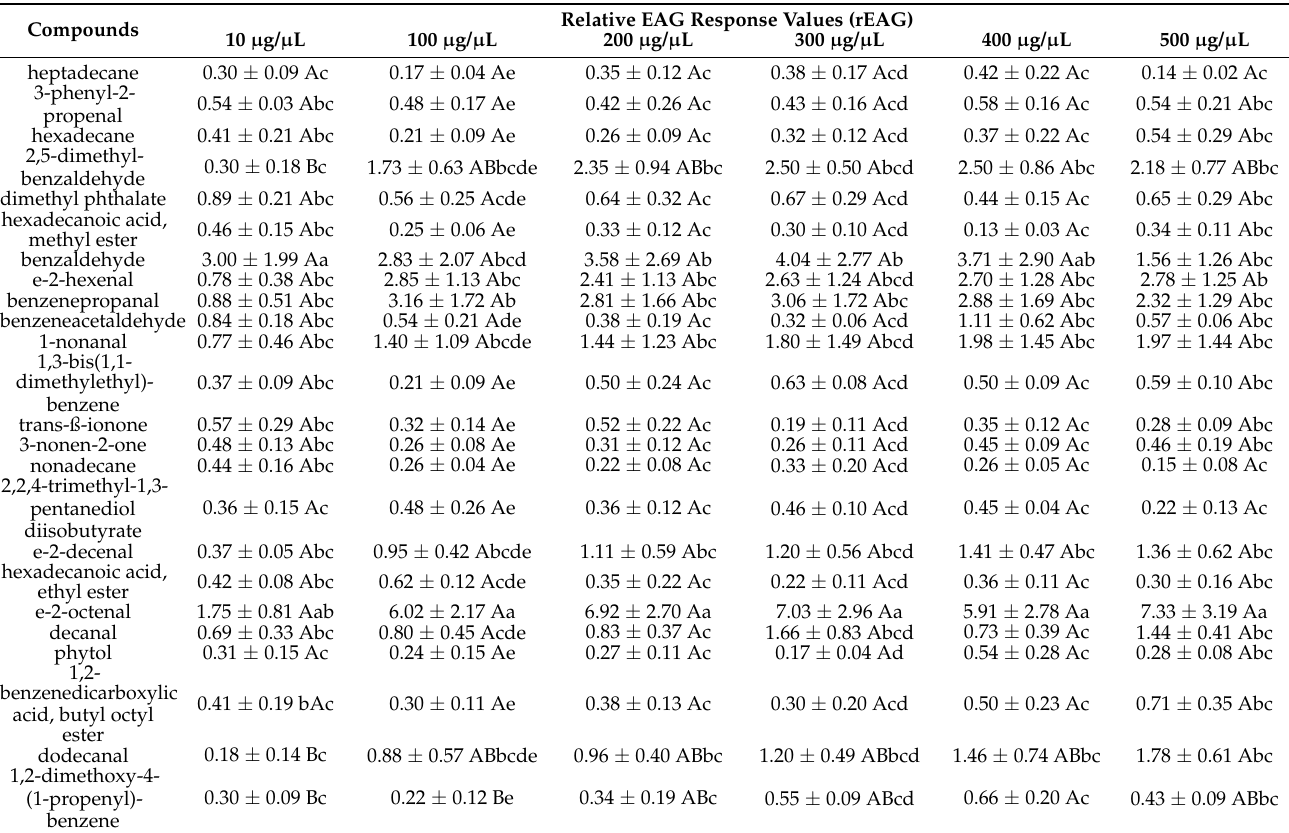
Table A2. The relative EAG response values of Bombus terrestris .